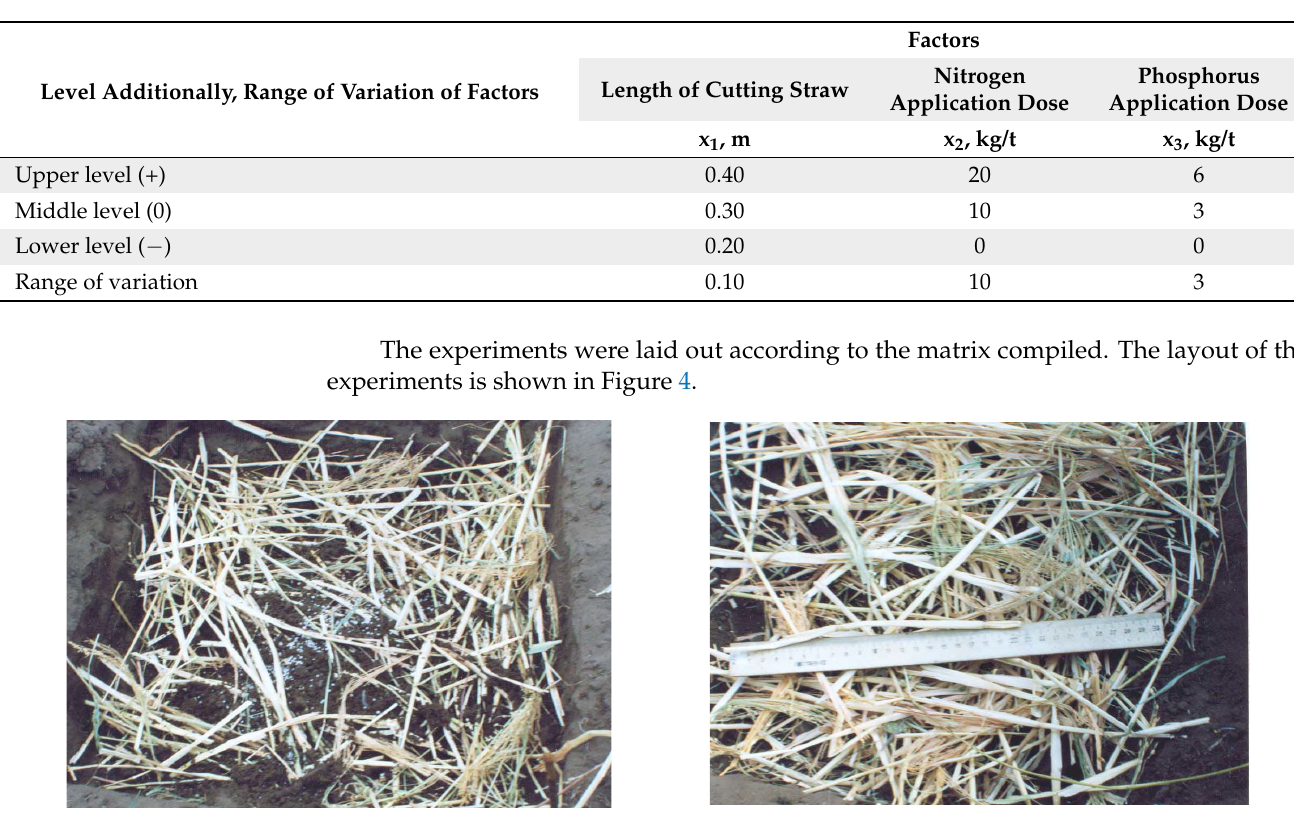
Table 2. Variation levels of factors.